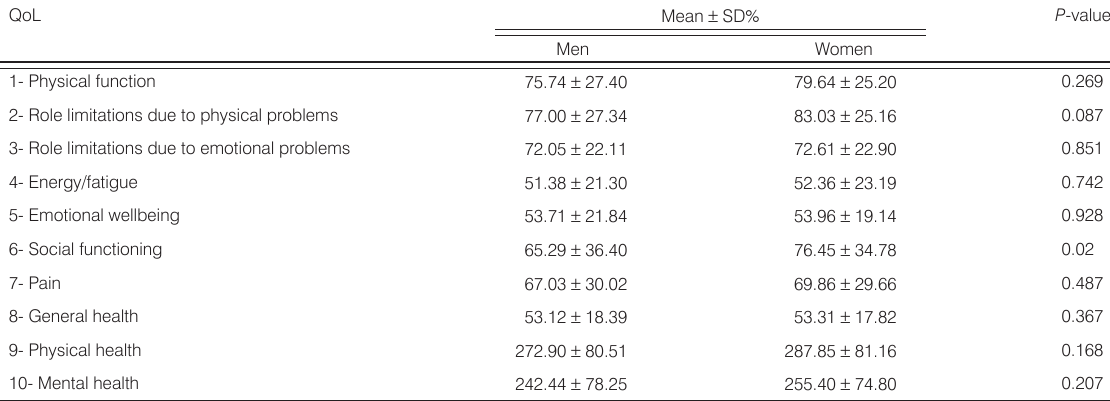
Table 5. QoL dimension score per gender